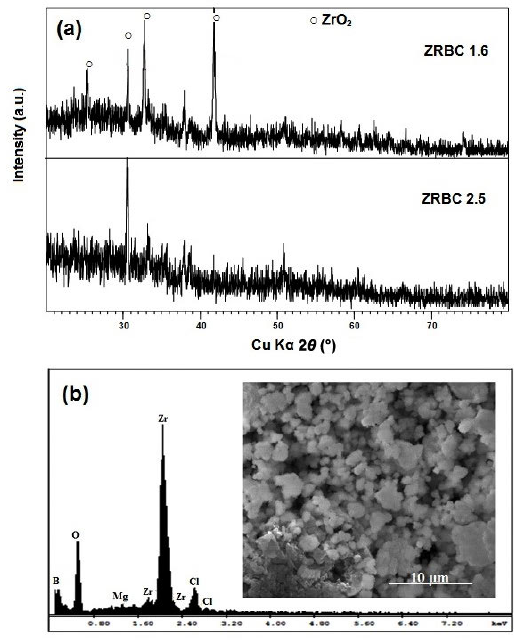
Fig. 5 (a) XRD patterns and (b) SEM image and EDS analysis of ZRBC after FT assisted reaction and leaching with concentrated HCl